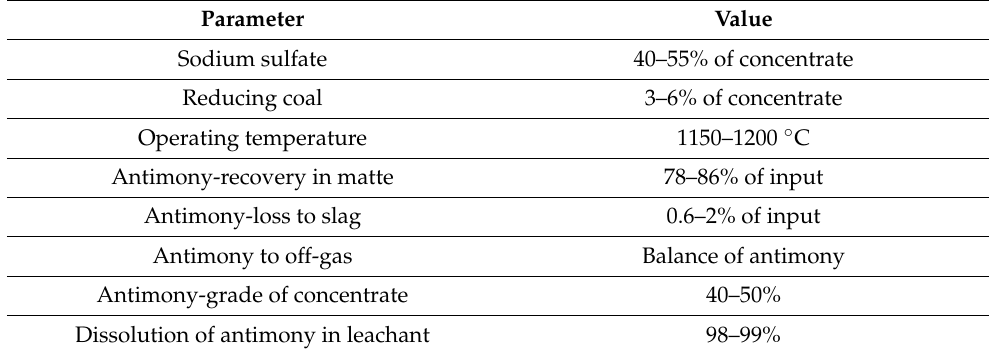
Table 7. Recommended parameters for matte smelting (adapted from